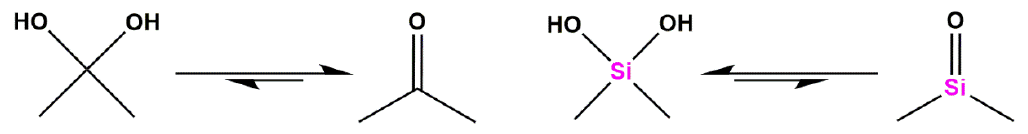
Figure 4. Hydration equilibrium for carbonyl (left) and silanone (right).